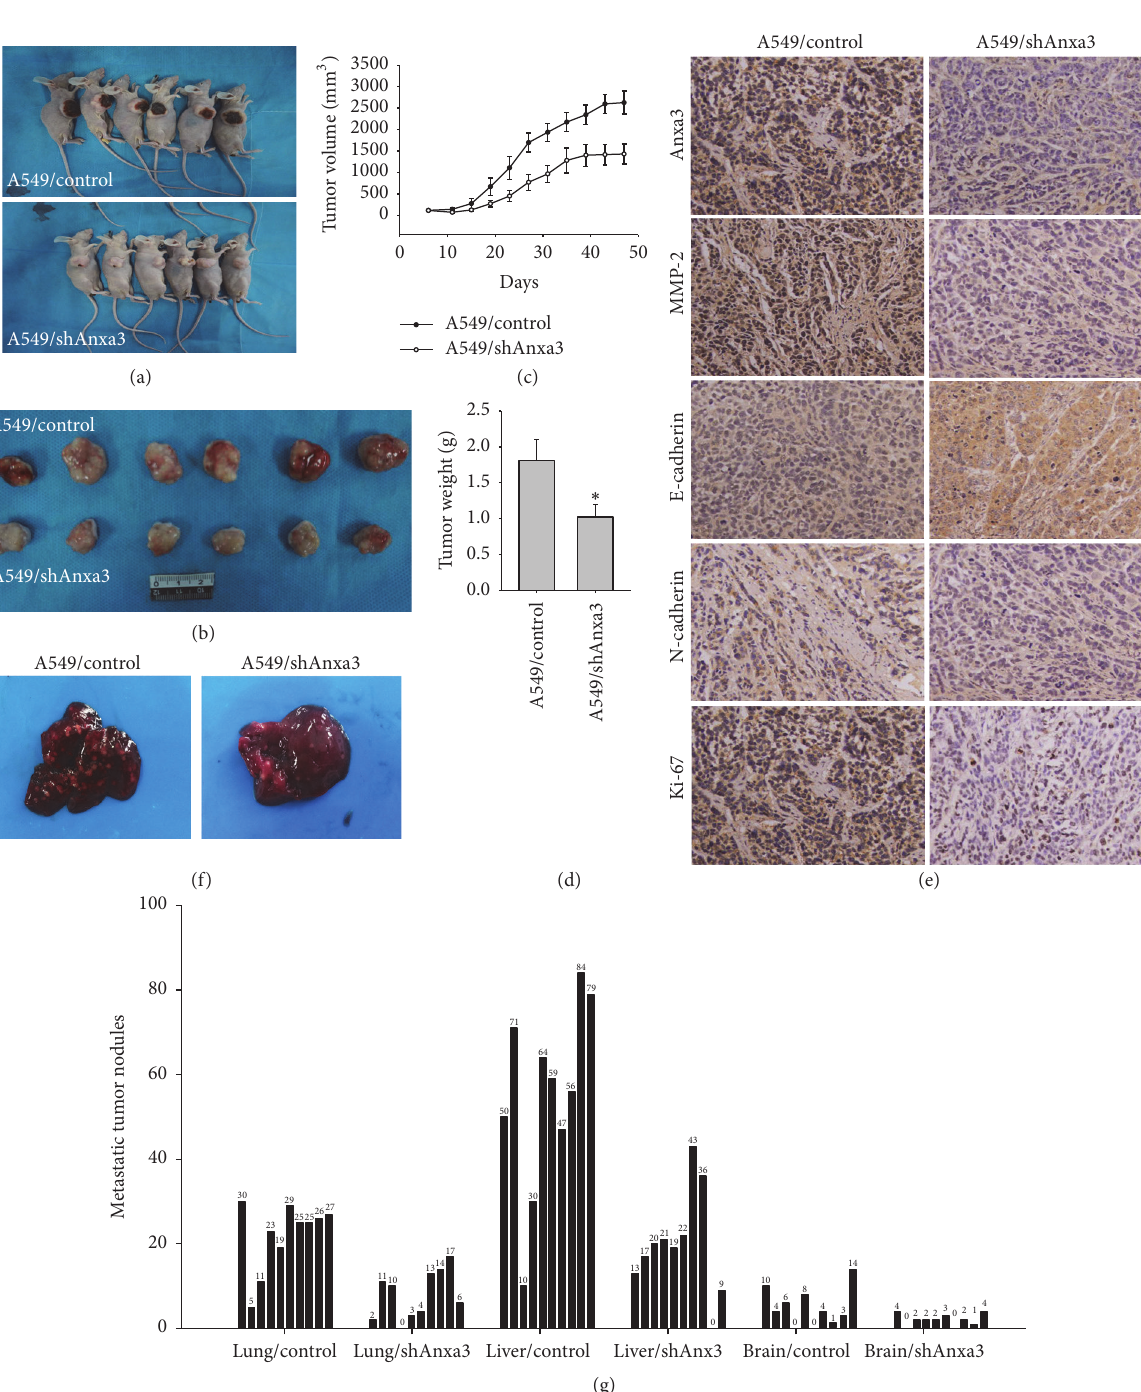
Figure 4: Downregulating Anxa3 expression inhibited tumor growth and tumor metastasis in vivo . Representative pictures of nude mice (a), tumor nodules (b), the curve of tumor growth (c), and the mean weights (d) of tumor nodules in A549/control and A549/shAnxa3 group were shown. ∗ indicates 𝑝 < 0.05 . Immunohistochemical analyses (e) of Anxa3, MMP-2, E-cadherin, N-cadherin, and Ki-67 expression in tissue sections of tumor nodules in the A549/control and A549/shAnxa3 groups were shown. Magnification: × 200. Representative pictures of metastatic tumor nodules in the livers (f) and histograms of metastatic tumor nodules (g) of lung, liver, and brain in the A549/control and A549/shAnxa3 groups were shown. ∗ indicates 𝑝 < 0.05